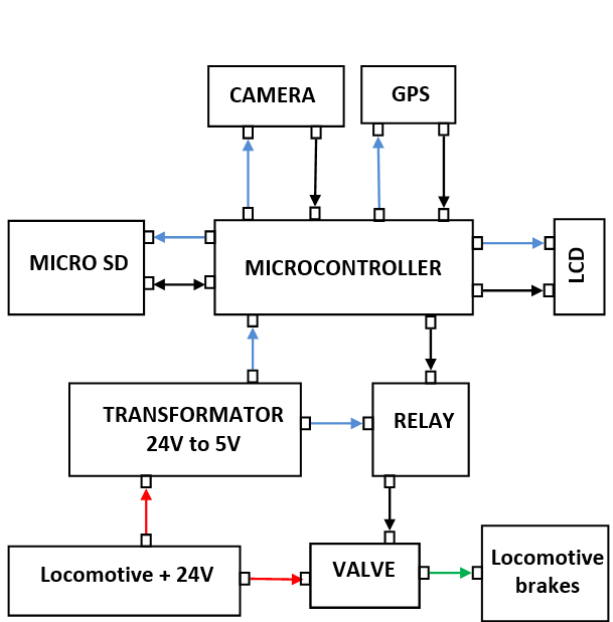
Fig. 2. Data and voltage flow scheme between system blocks and elements. Red arrows show 24 V voltage flow, blue arrows – 5 V voltage flow, black arrows – dataflow and green arrows – mechanical impact.